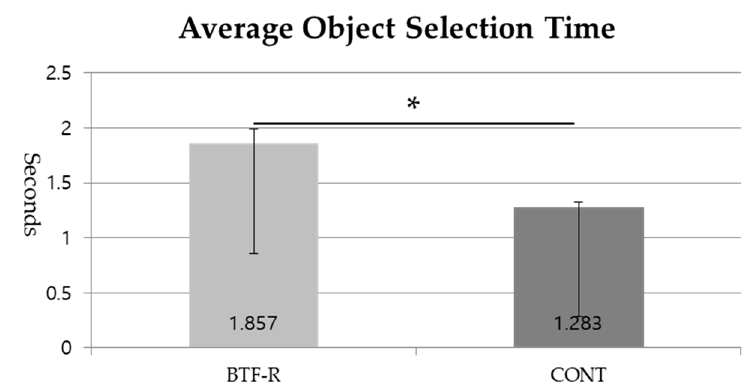
Figure 13. The average selection time between BTF-F and CONT with objects with sizes below 0.4 cm. The asterisk mark (*) indicates statistically significant difference.